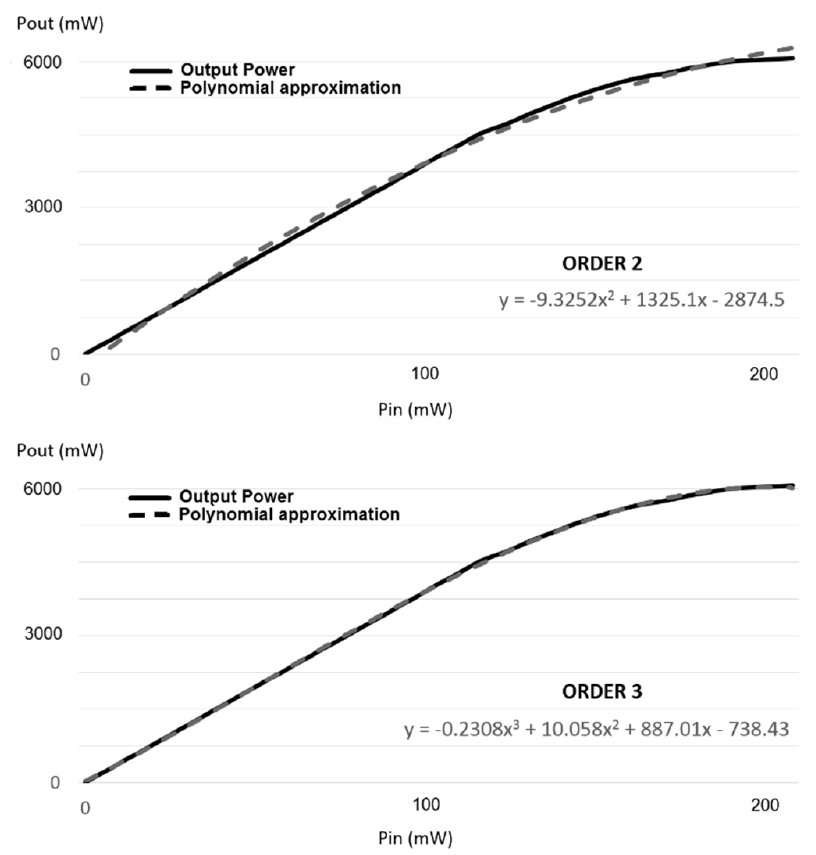
Figure 8. Output power versus input power for a GaN NPTB00004A amplifier (continuous line) and the polynomial approximation (dash line) when the polynomial order is changed (top: order 2, bottom: order 3).